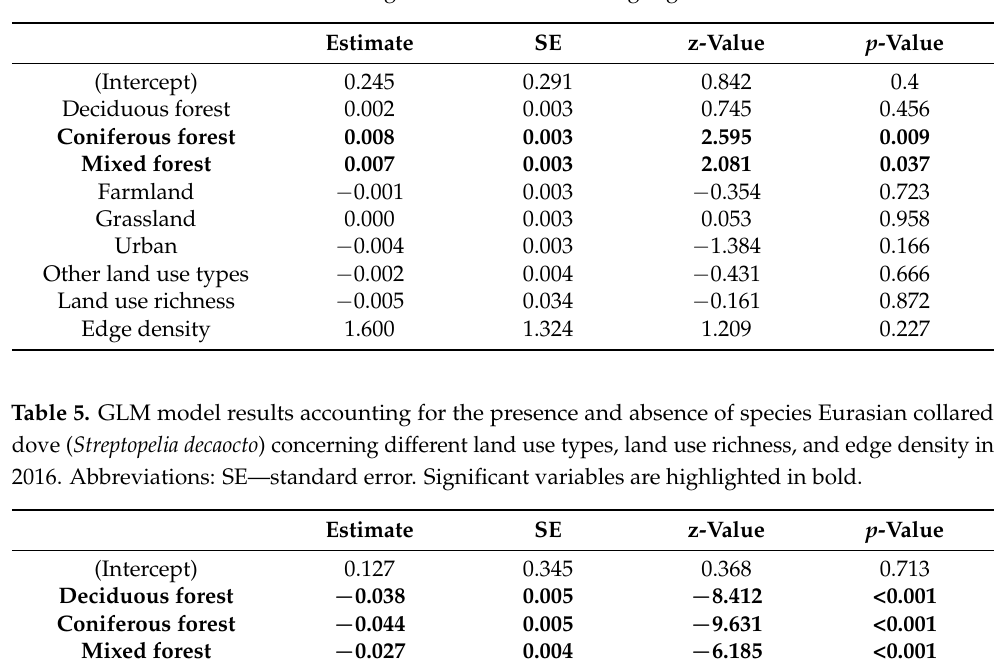
Table 4. GLM model results accounting for the presence and absence of species wood pigeon ( Columba palumbus ) concerning different land use types, land use richness, and edge density in 2016. Abbreviations: SE—standard error. Significant variables are highlighted in bold.